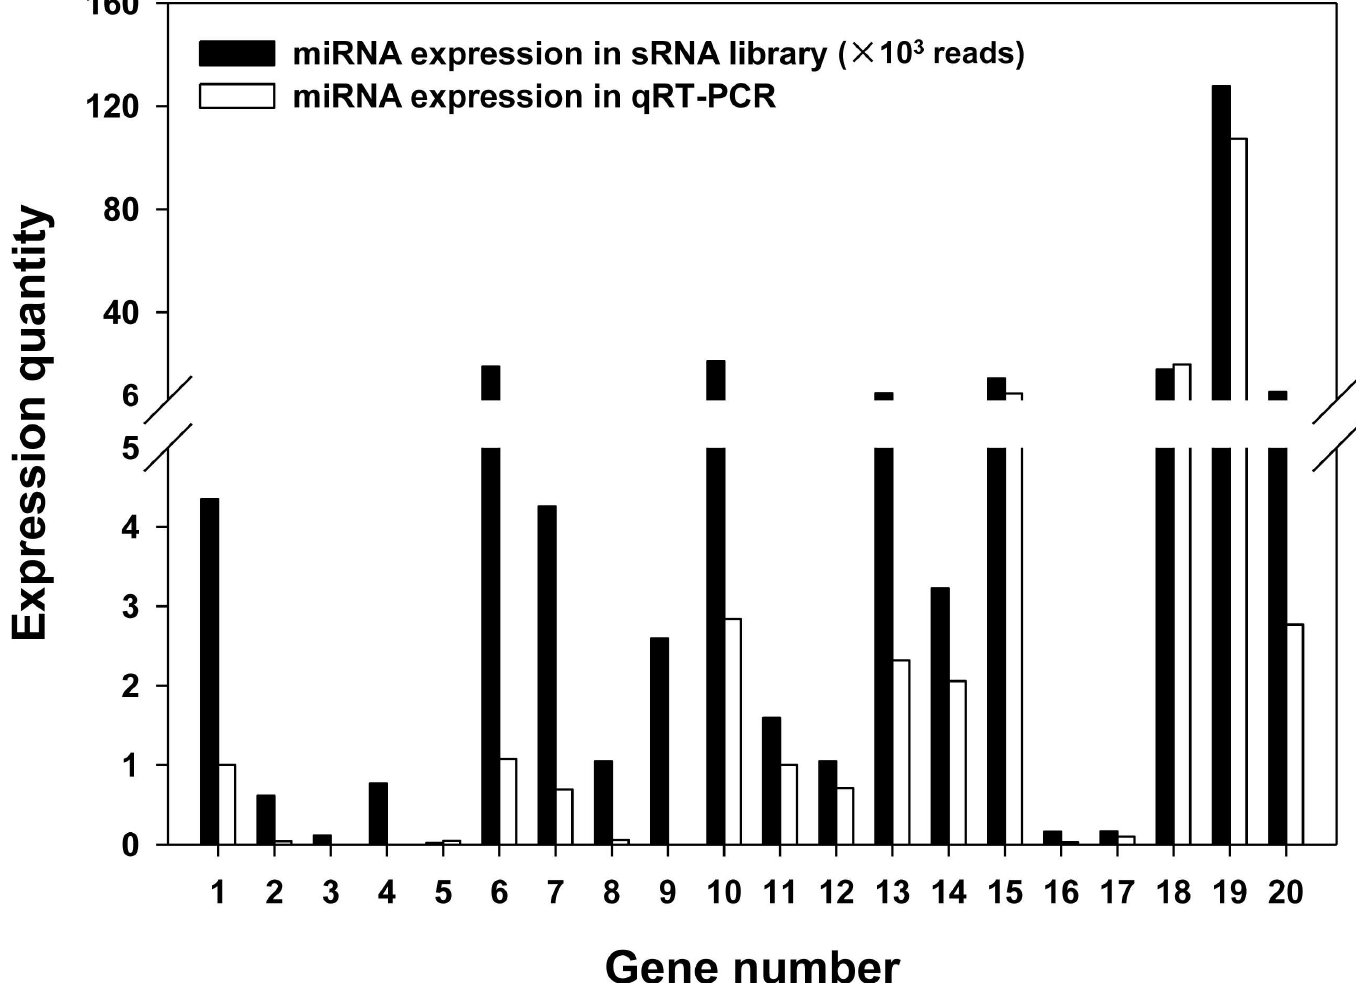
Fig 4. Comparative analysis of qPCR detection with the expressional profiling in sRNA sequencing. The y -axis indicatesthe abundance of miRNAs in the sRNA library and the relative transcriptional level of miRNAs detected using qPCR. The x -axis representsthe specific assessedmiRNAs, as 1: let-7, 2: mse92a, 3: bmo998,4: pxy-6497-p5, 5: pxy-6497-p3, 6: bmo2b, 7: bmo281,8: bmo279a, 9: bmo9a, 10: bmo305,11: PC-5P-671,12: PC-5P-1276, 13: PC- 3P-1433,14: PC-3P-4029, 15: PC-3P-16268, 16: PC-5P-35148, 17: PC-5P-15,18: PC-5P-1018, 19: PC-5P-1258, 20: PC-3P-598.